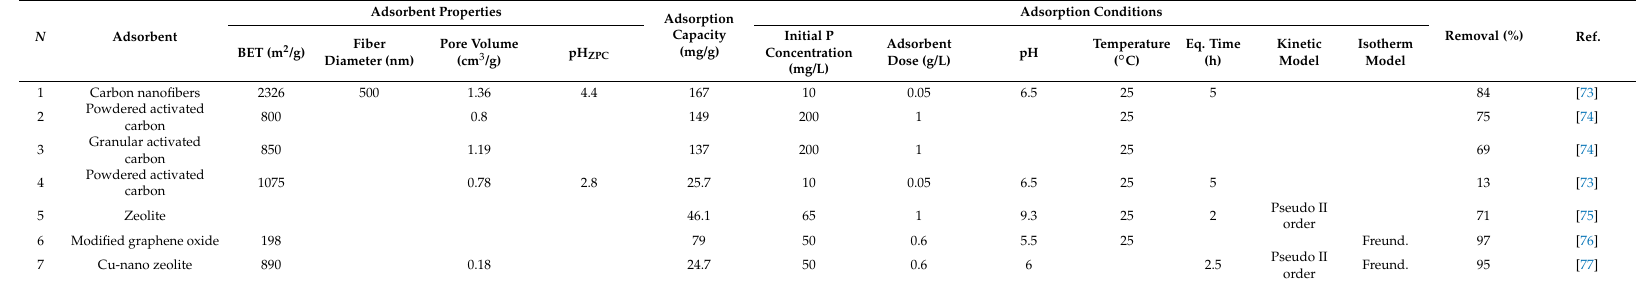
Table 8. Nanofibrous adsorbent properties and adsorption conditions for the removal of